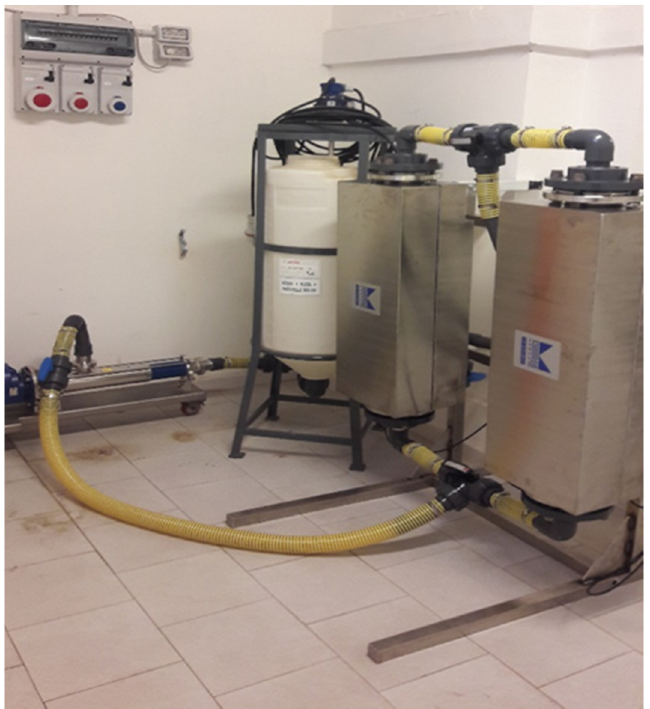
Figure 17. Multi-frequency US devices (20–120 kHz) working in flow mode (max. power of 2 kW). Weber Ultrasonics AG [30].